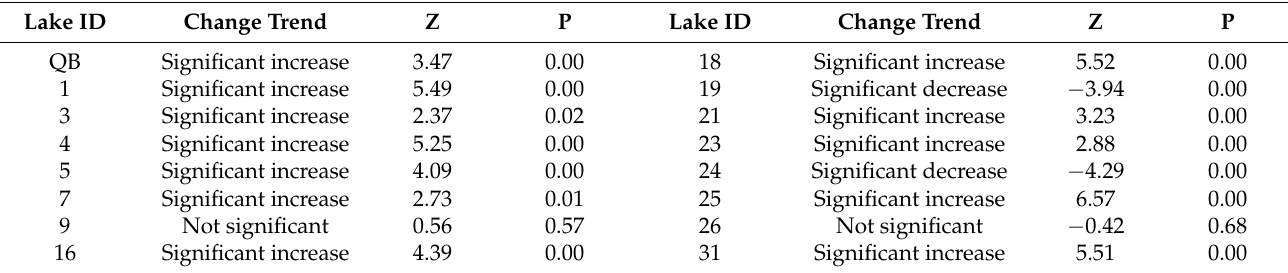
Table 3. Trend of change in lake water storage in the Qaidam Basin from 1990 to